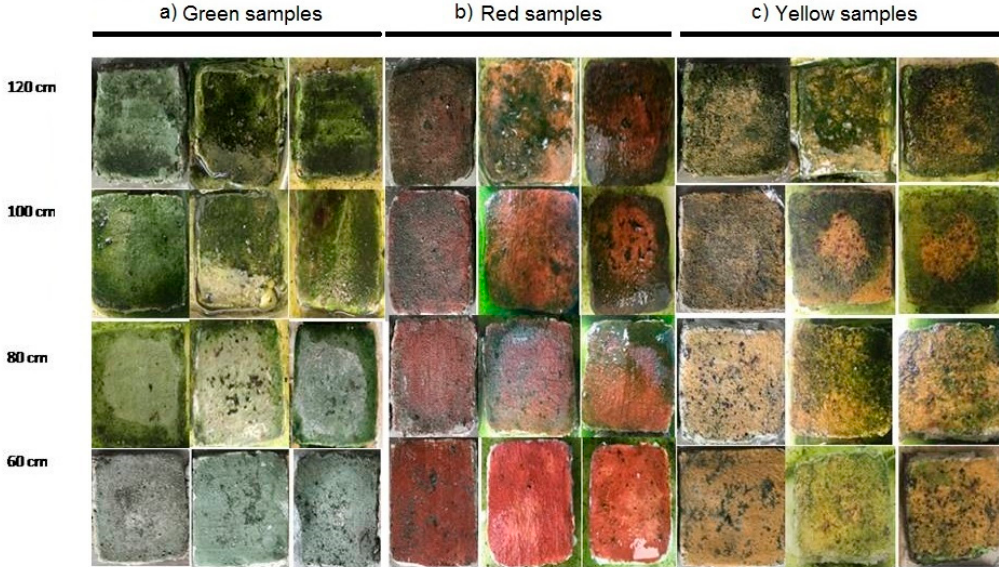
Figure 1. Samples used for inoculation with a mixture of cyanobacteria and green algae at different distances (120, 100, 80, 60 cm). ( a ) green samples; ( b ) red samples; ( c ) yellow samples.